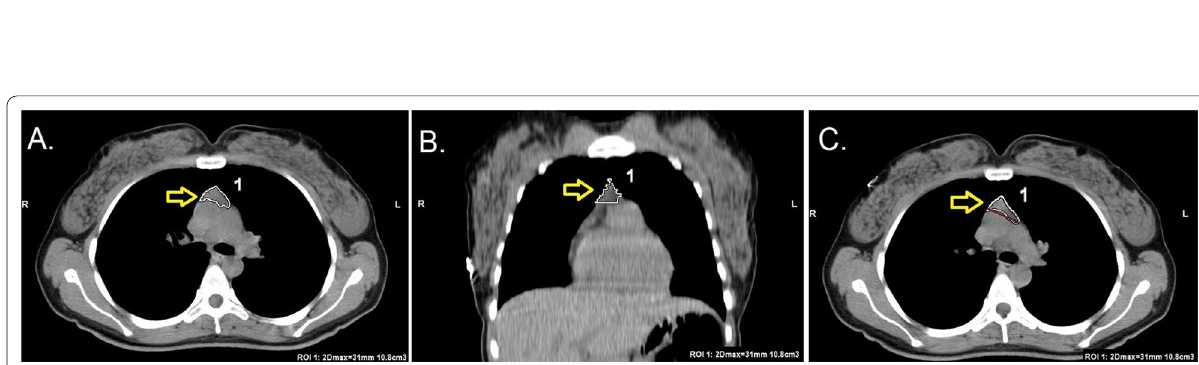
Fig. 5 Measurements of thymus with auto contour tool; A and B shows automated and manually fine tuned thymus contours. C Automatically measured maximum diameter